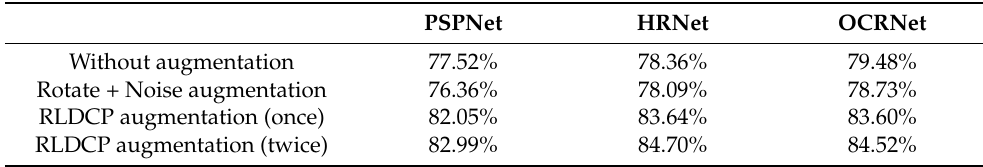
Table 3. Comparison of MIoU of different augmentation